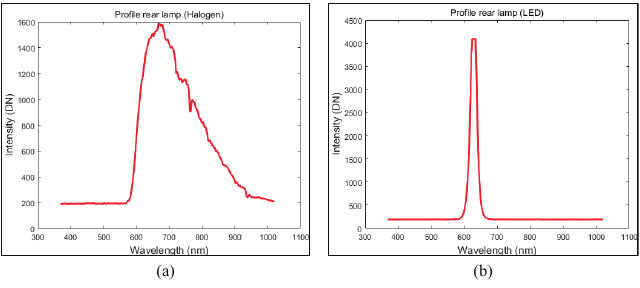
Figure 17. Spectral information rear lamp: ( a ) Halogen rear lamp ( b ) LED rear lamp.